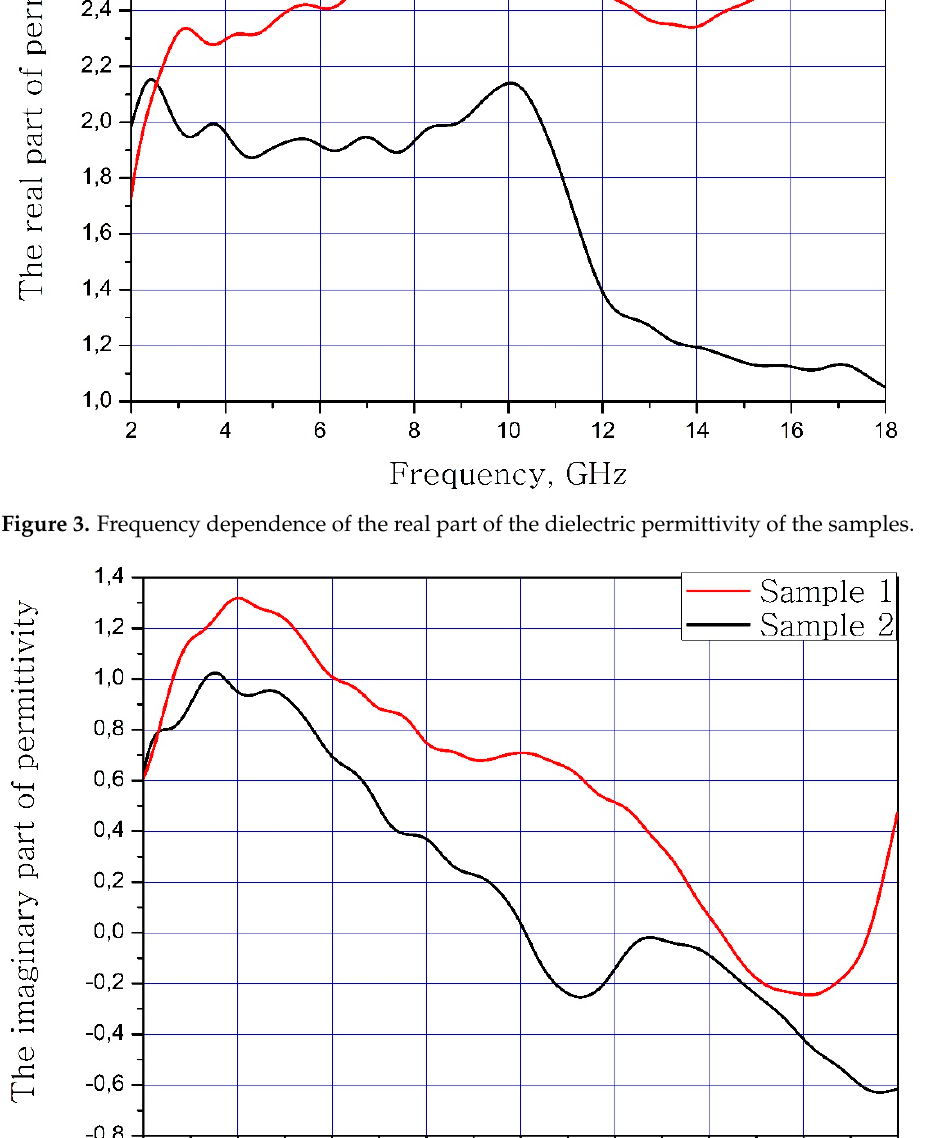
Figure 5. Frequency dependence of the real part of the magnetic permeability of the samples.